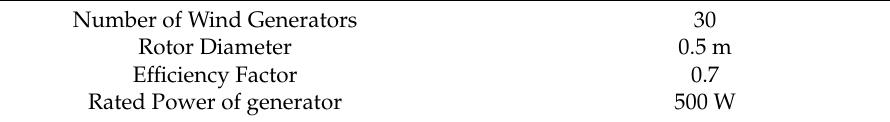
Table 6. Technical data of Wind Generator WECs.